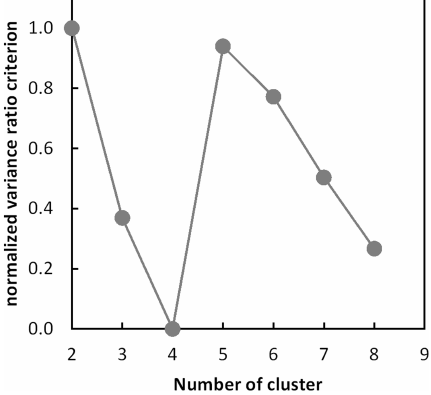
Fig. 6. Normalised variance ratio criterion as a function of the opti- mum number of